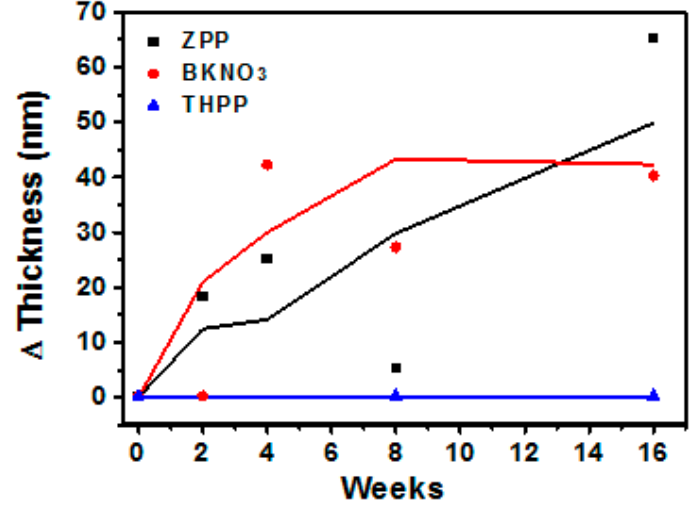
Figure 3. The thickness change of oxide shell vs. aging time. The aging effect has the order of ZPP >> BKNO 3 > THPP [7,8].